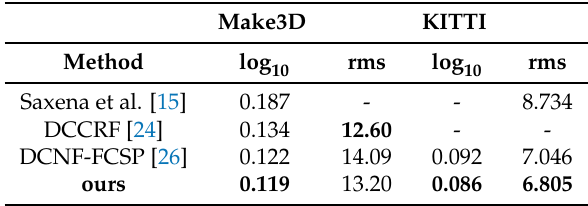
Table 1. Depth estimation using the state-of-the-art and our refined depth. We compare on the Make3D and KITTI